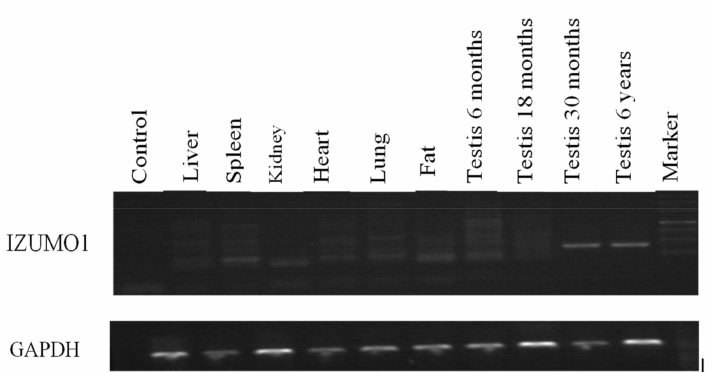
Figure 1. Expression of IZUMO1 mRNA by semi-quantitative PCR in various tissues of Datong yak.